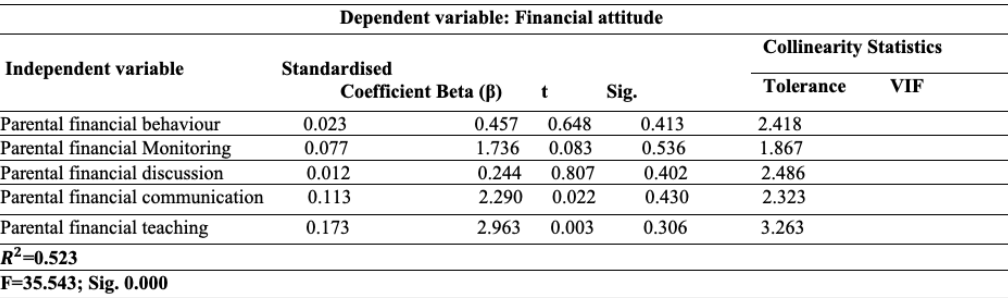
Table 3: Multiple regression analysis for parental financial socialisation and financial